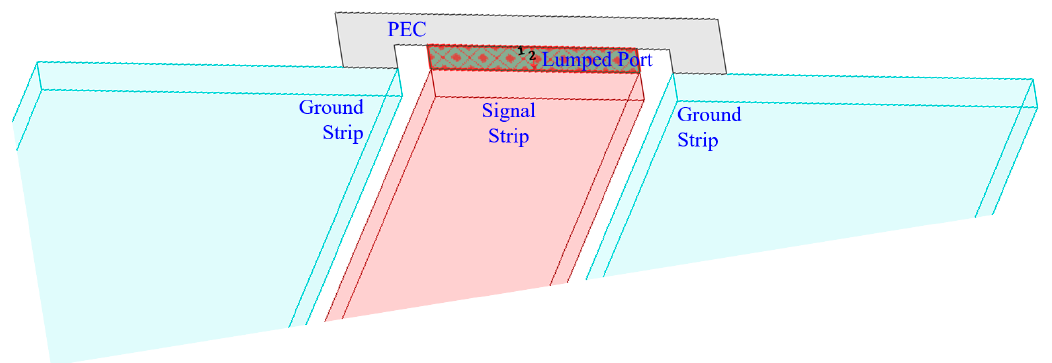
Figure 11. Ground–signal–ground probe modelling in HFSS.